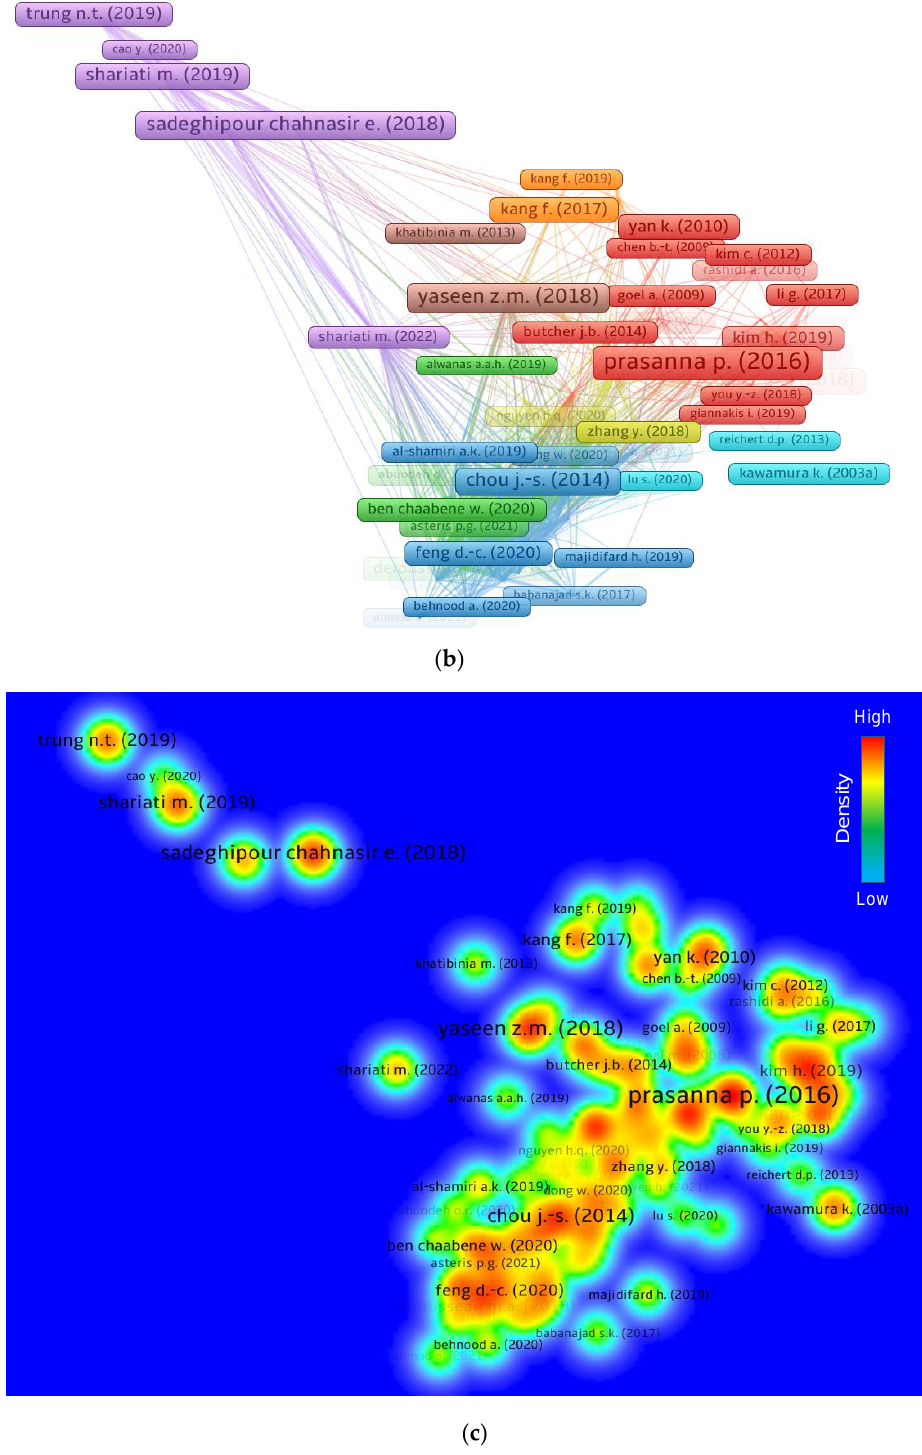
Figure 9. Systematic map of published documents up to May 2022: ( a ) documents with at least 30 citations; ( b ) linked documents based on citations; ( c ) density of connected documents.